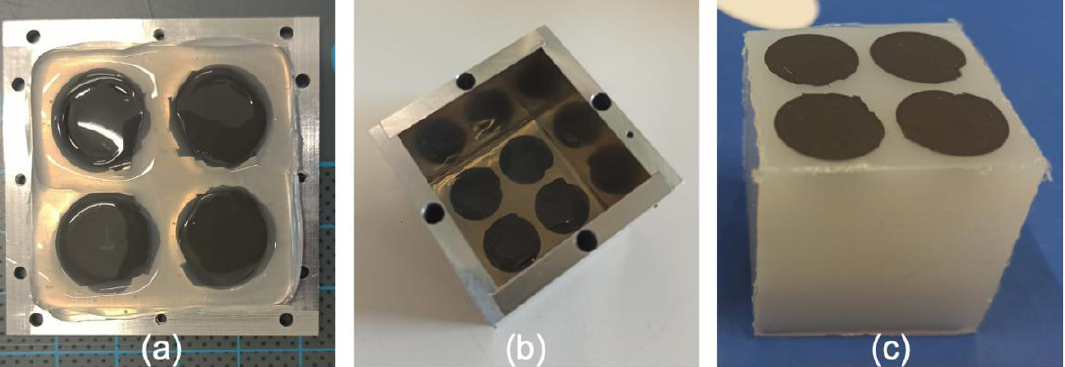
Figure 10. ( a ) 3D printed heterogeneous magnetic layer obtained with the printing parameters described in the previous sections and placed at the bottom of a mold; ( b ) mold after assembly of the walls; and ( c ) final 40 mm × 40 mm × 40 mm system composed of a heterogeneous magnetic layer resting on a soft non-magnetic substrate.